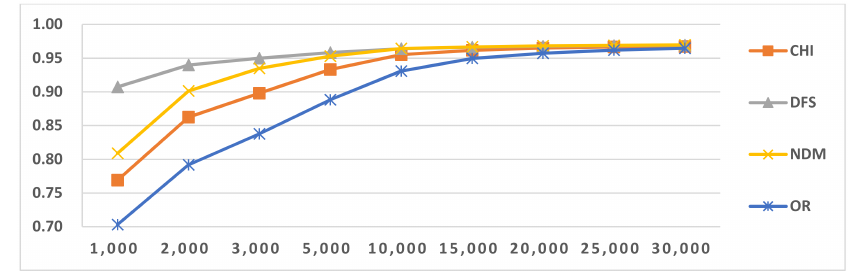
Figure 10. Results of LI in Latin mix-gram (2–4) Latin script